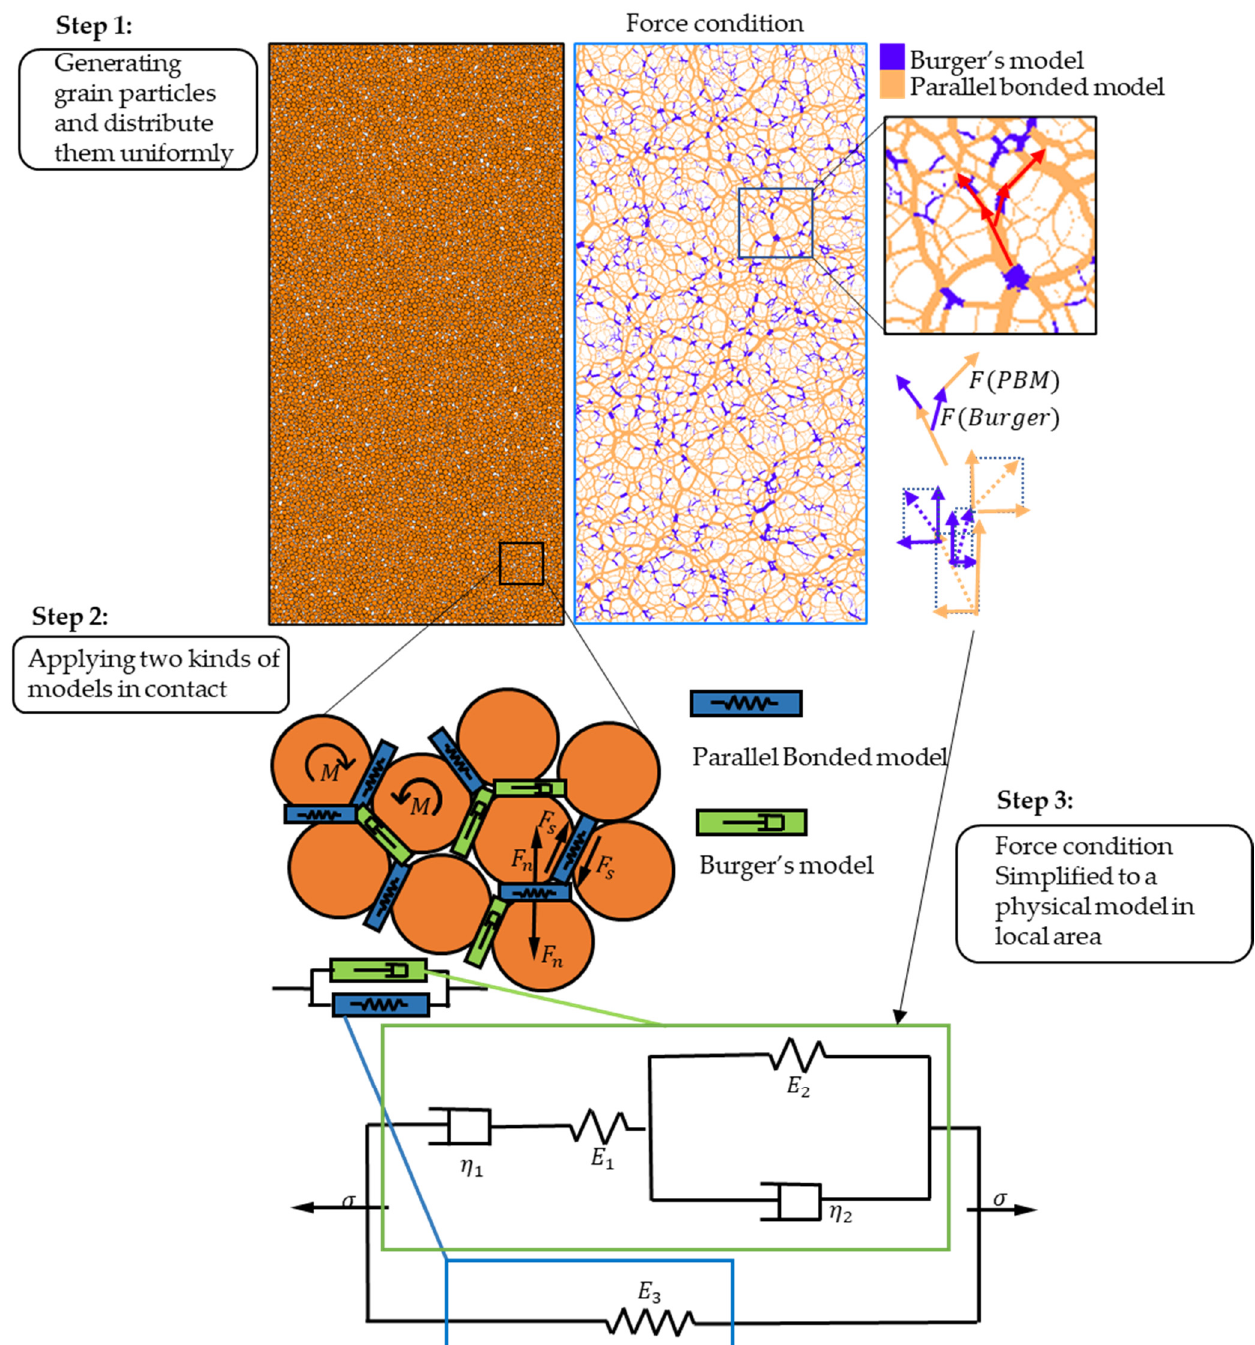
Figure 2. The schematical process of DEM simulation method.